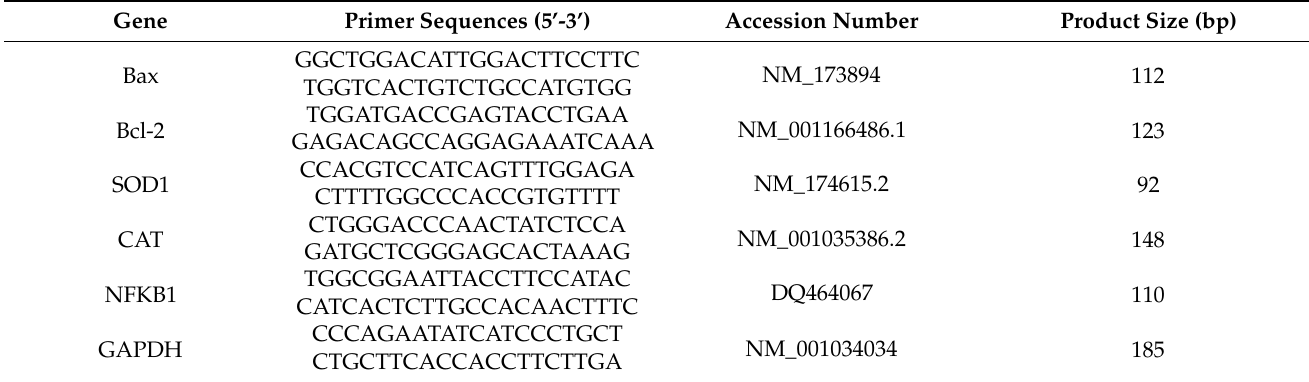
Table 1. Primers used in this